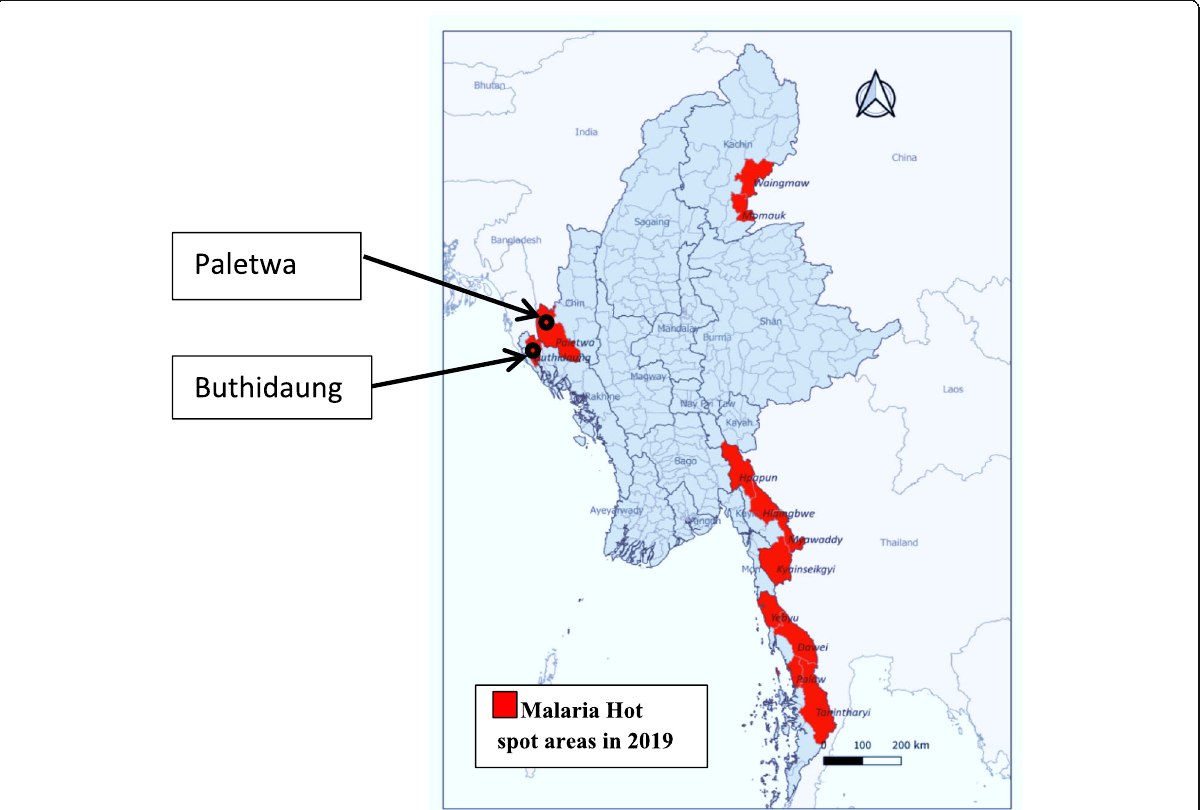
Fig. 1 Map showing study sites among malaria hot spot areas of Myanmar in